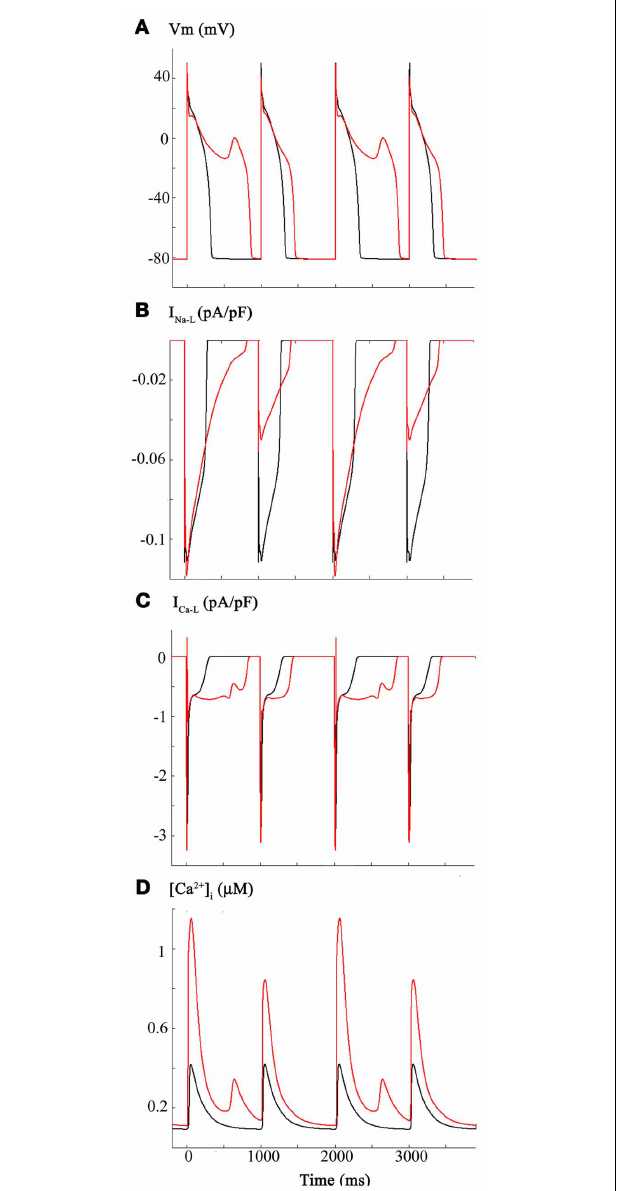
FIGURE 2 | Effects of CO-induced changes in L-type Ca 2 + current on the human ventricular myocyte. Based on the work of Campbell et al., I Ca - L was increased 50% and the voltage dependence for the activation curve was shifted in the depolarizing direction by 3mV. As shown in Panel (A) these changes resulted in a lengthening of the action potential plateau and appearance of associated oscillatory potentials or early after depolarizations (EADs). Panel (B) shows the changes in I Na - L . The longer APD results in a protracted I Na - L ; the alterations in amplitude of this current are due to the voltage dependence of its reactivation. As shown in Panel (C) , these changes in the biophysical parameters that regulate I Ca - L resulted in a change in peak amplitude and perhaps more importantly a significant alteration in its time course of inactivation. I Ca - L also reactivates under these conditions. Panel (D) shows the control Ca 2 + transient and the computed changes in [Ca 2 + ] i that occur as a consequence of alterations in the I Ca - L